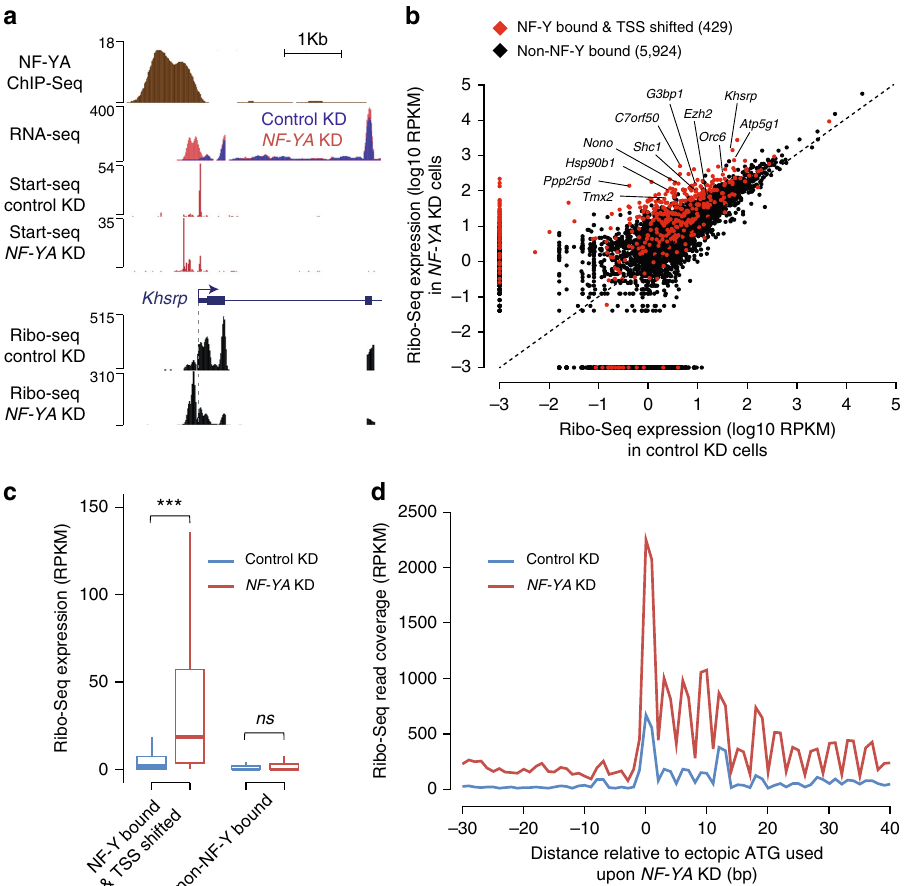
Fig. 4 Transcripts originating from ectopic TSSs in NF-Y-depleted cells undergo translation. a Genome browser shot of NF-Y target gene Khsrp showing ribosome-protected RNA expression, as measured using Ribo-Seq, in control and NF-YA KD ESCs. Also shown are tracks for NF-YA ChIP-Seq, and RNA- Seq and Start-Seq in control and NF-YA KD ESCs. b Scatter plot showing the Ribo-Seq expression (coverage), in control ( x -axis) and NF-YA KD ( y -axis) ESCs, of the region between the ectopic (shifted) TSS and 25 bp upstream of the canonical TSS of genes with promoter-proximal NF-Y binding that exhibit a TSS shift (red). For comparison purposes, Ribo-Seq expression of the region between 115 bp (median TSS shift distance) and 25 bp upstream of TSS of genes with no promoter-proximal NF-Y binding is shown (black). RPKM, reads per kilobase per million mapped reads. c Box plot showing the Ribo-Seq expression, in control (blue) and NF-YA KD (red) ESCs, of the region between the ectopic TSS and 25 bp upstream of the canonical TSS of genes with promoter-proximal NF-Y binding that exhibit an ectopic TSS. For comparison purposes, Ribo-Seq expression of the region between 115 bp (median TSS shift distance) and 25 bp upstream of TSS of genes with no promoter-proximal NF-Y binding is shown. *** P -value = 8.21E-39 (Wilcoxon rank-sum test, two- sided). d Ribo-Seq read coverage, centered on the most likely ectopic start codon (ATG), in control and NF-YA KD ESCs. Only genes with promoter- proximal NF-Y binding that exhibit an ectopic TSS in NF-YA KD ESCs were used ( n